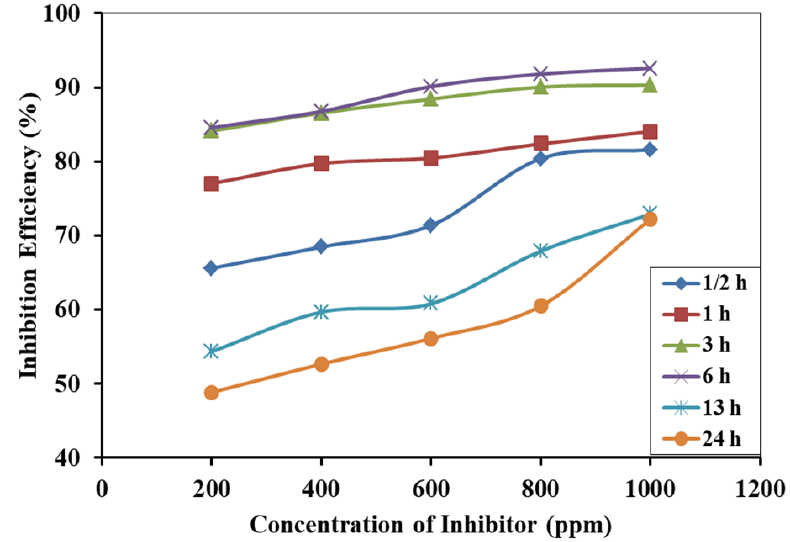
Figure 4. The inhibition efficiency of AV alkaloid solution in 1 M H 2 SO 4 for mild steel at different immersion times.